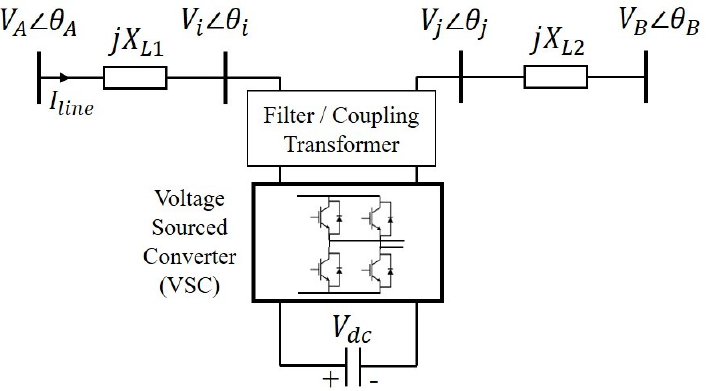
Figure 11. Representation of the Static Synchronous Series Compensation (SSSC) based on a voltage- sourced converter (VSC). Adapted from Reference